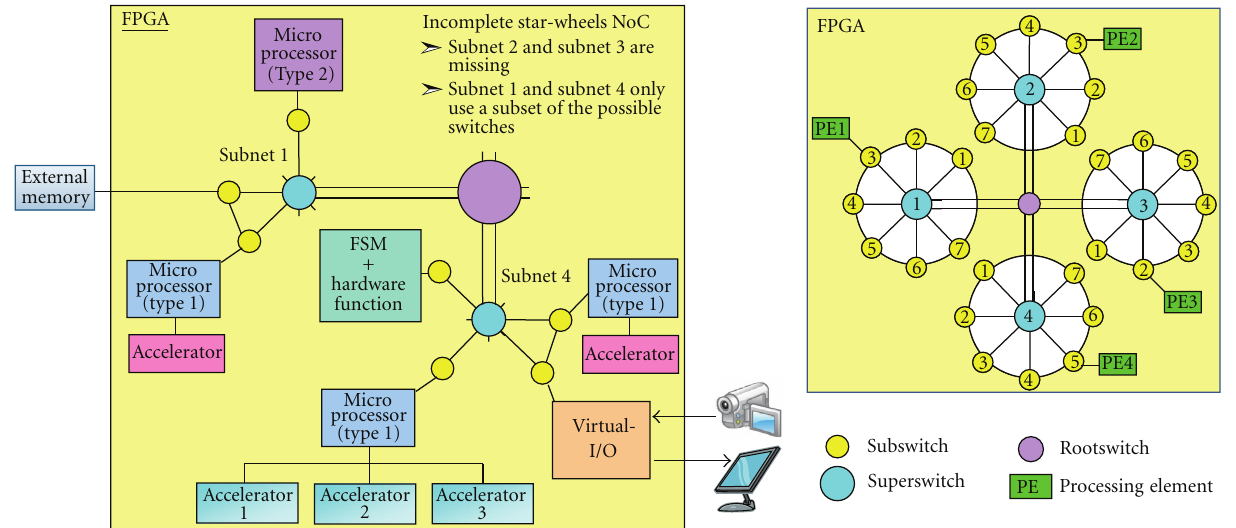
Figure 1: Example of an RAMPSoC architecture connected over an incomplete star-wheels network-on-chip. For comparison, on the top right side, an example of a complete star-wheels NoC is